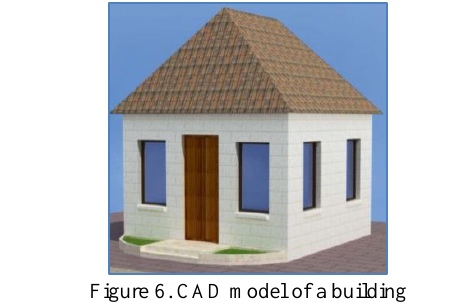
Figure 6. CAD model of a building